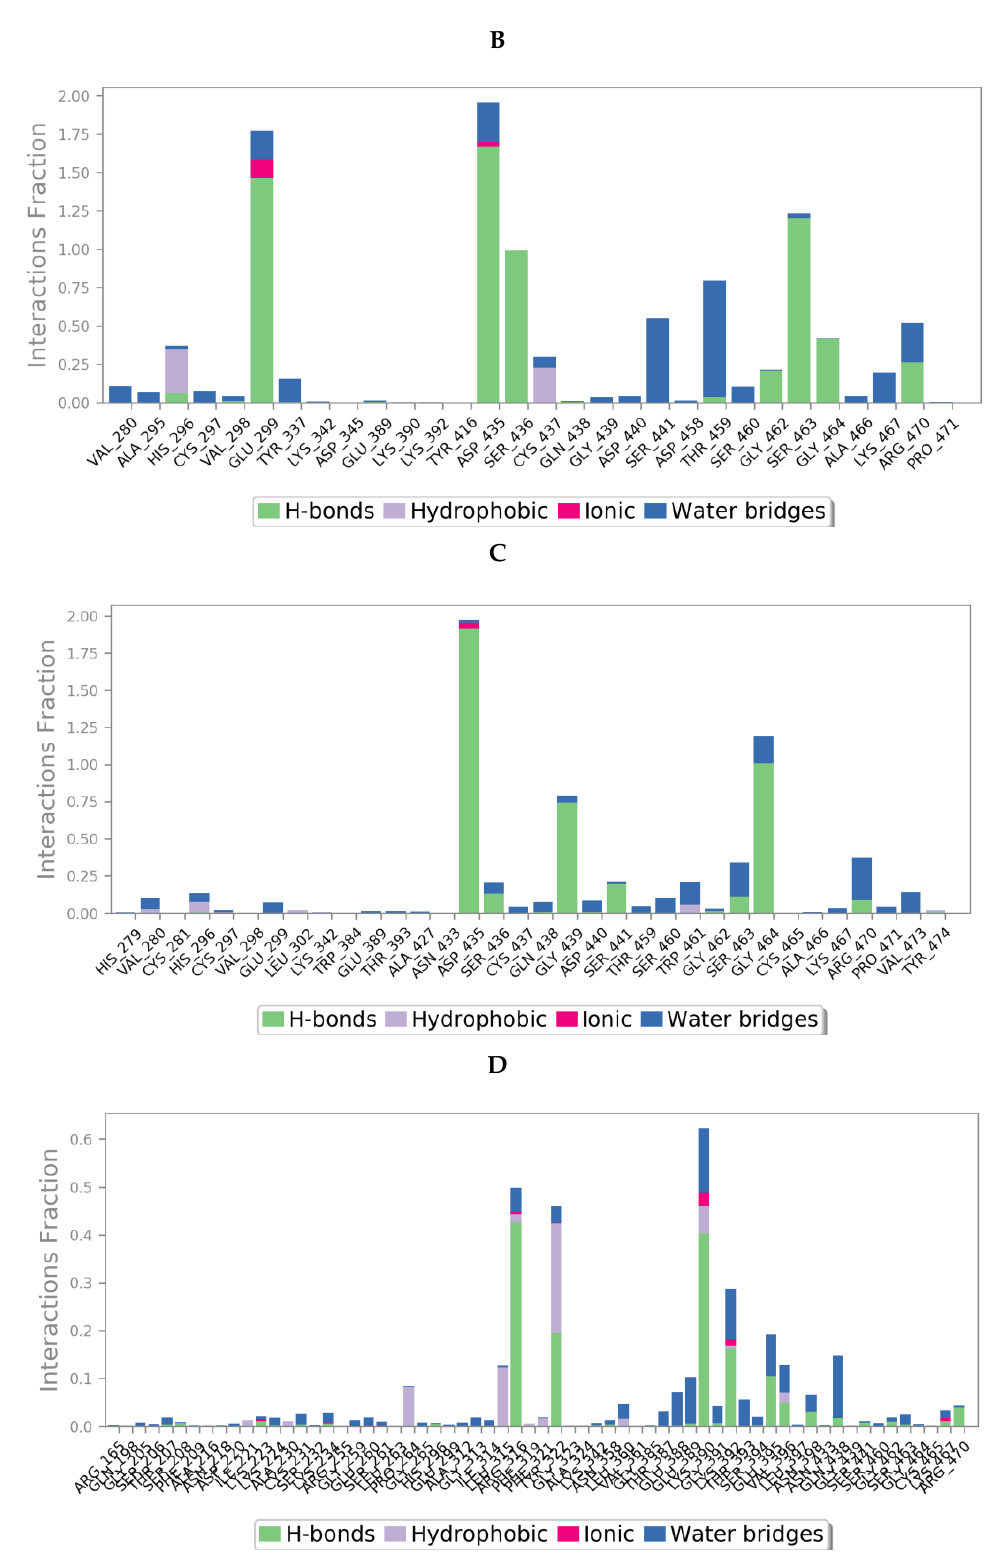
Figure 13. A schematic of detailed ligand atom interactions of ( A ) camostat, ( B ) nafamostat, ( C ) gabexate and ( D ) sivelestat with the protein residues of TMPS2 protein. Interactions that occur more than 30.0% of the simulation time in the selected trajectory (0 through 200 ns) are shown. [Hydrophobic (purple), water bridges (blue), H-bonds (green), ionic (pink)].